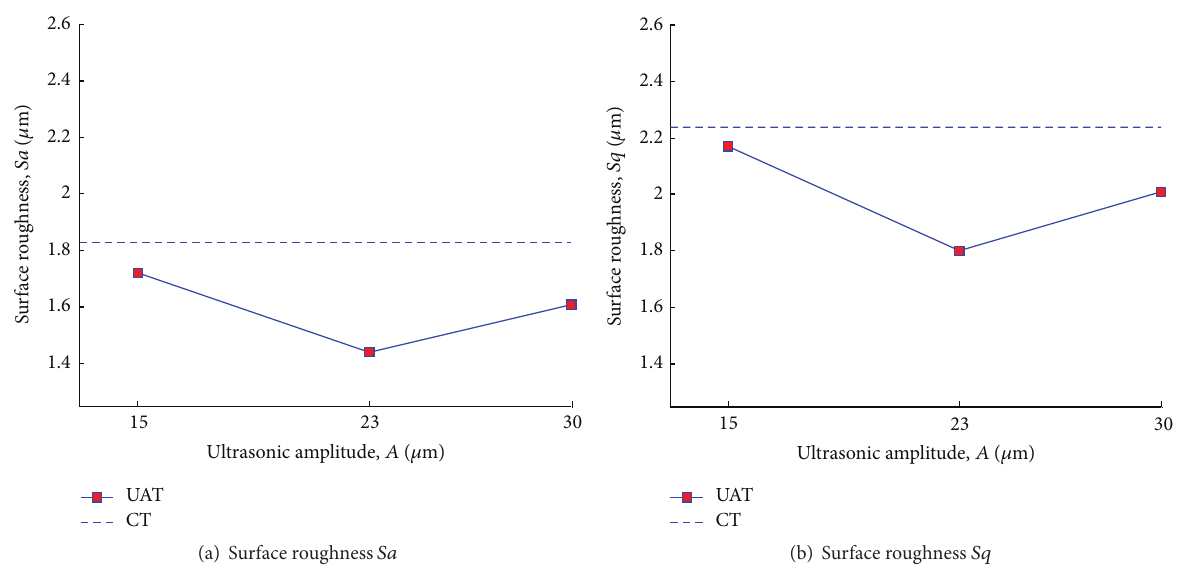
Figure 17: Relation curve of surface roughness changed with ultrasonic